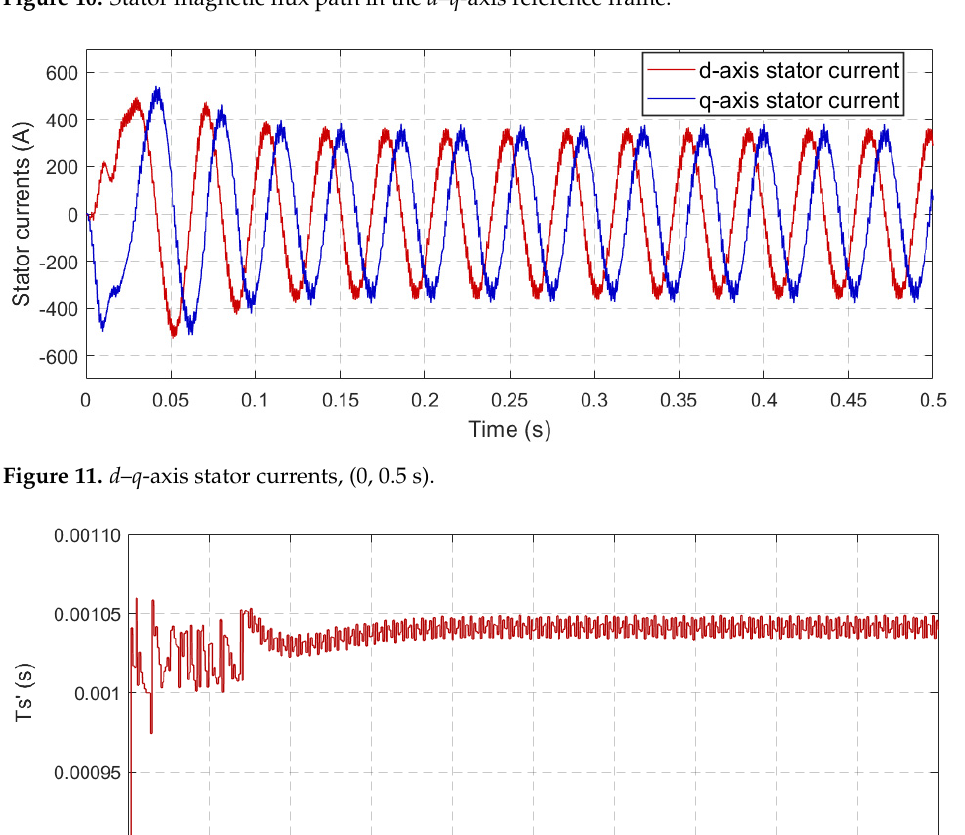
Figure 12. The SVPWM time period T s ′ .